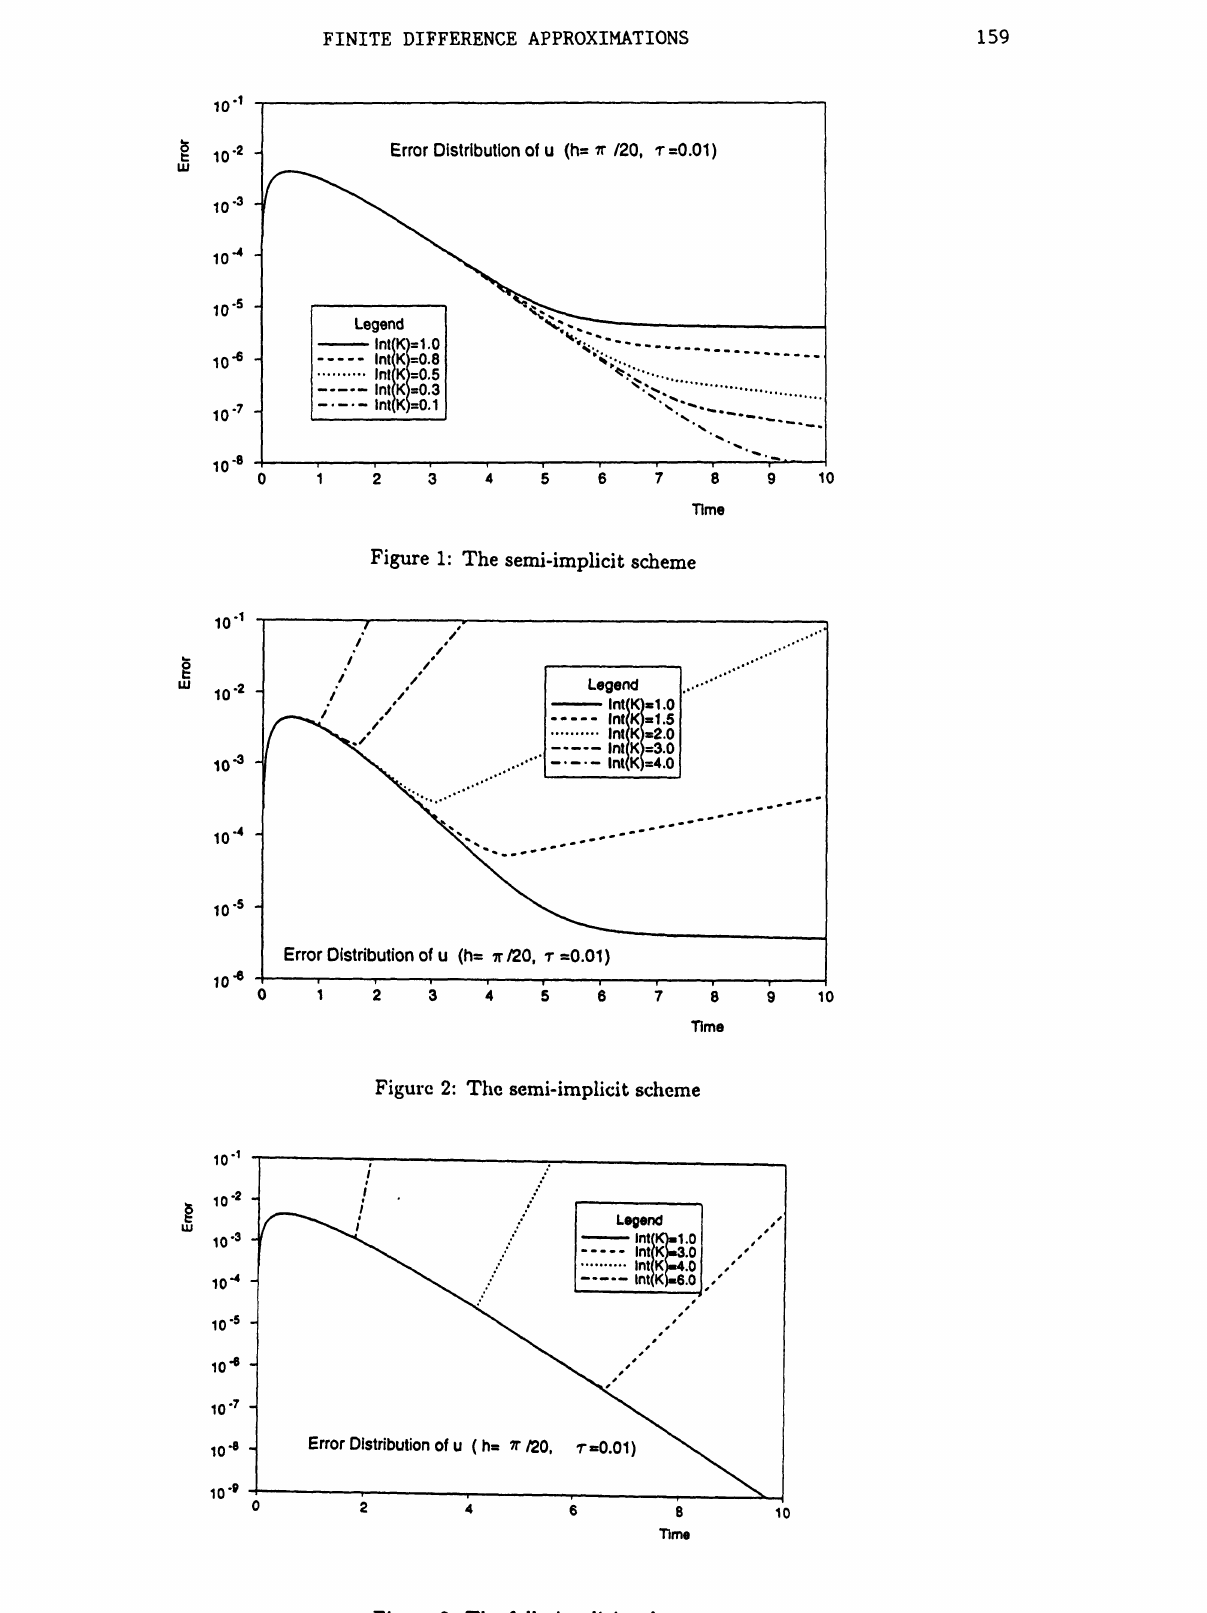
Figure 3: The fully-implicit